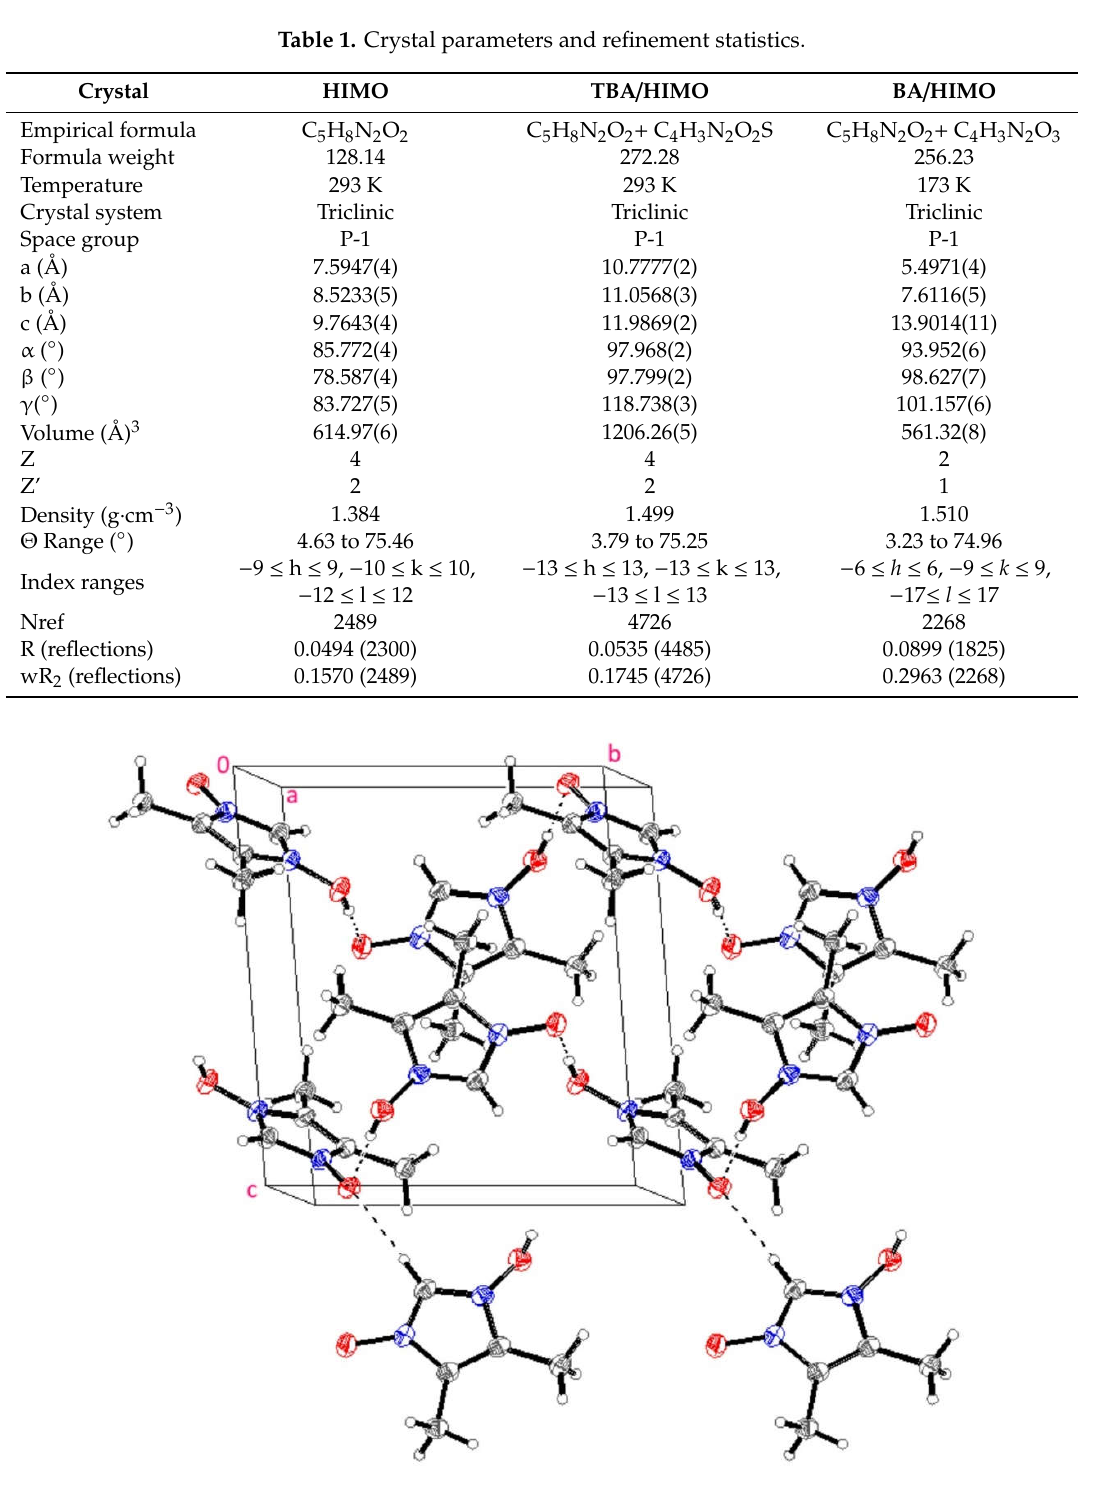
Figure 11. Molecular packing of HIMO.